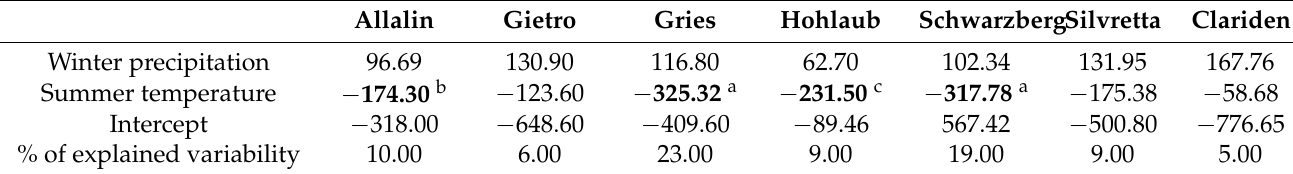
Table 7. Multiple regression coefficients for winter precipitation and summer temperature explaining B a variation of Swiss glaciers. Superscripts a–c indicate significance at p < 0.01, 0.05, and 0.10,